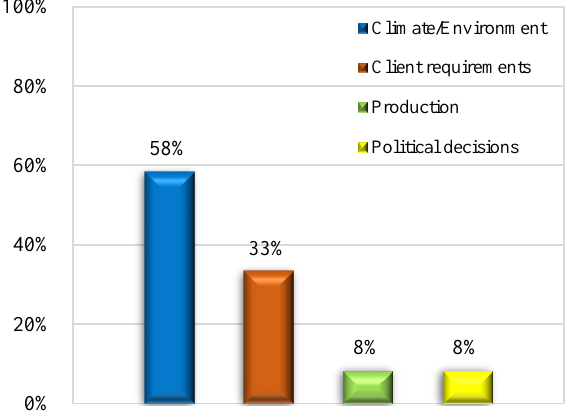
Figure 1. Reasons of ERs for constructing with wooden frames.